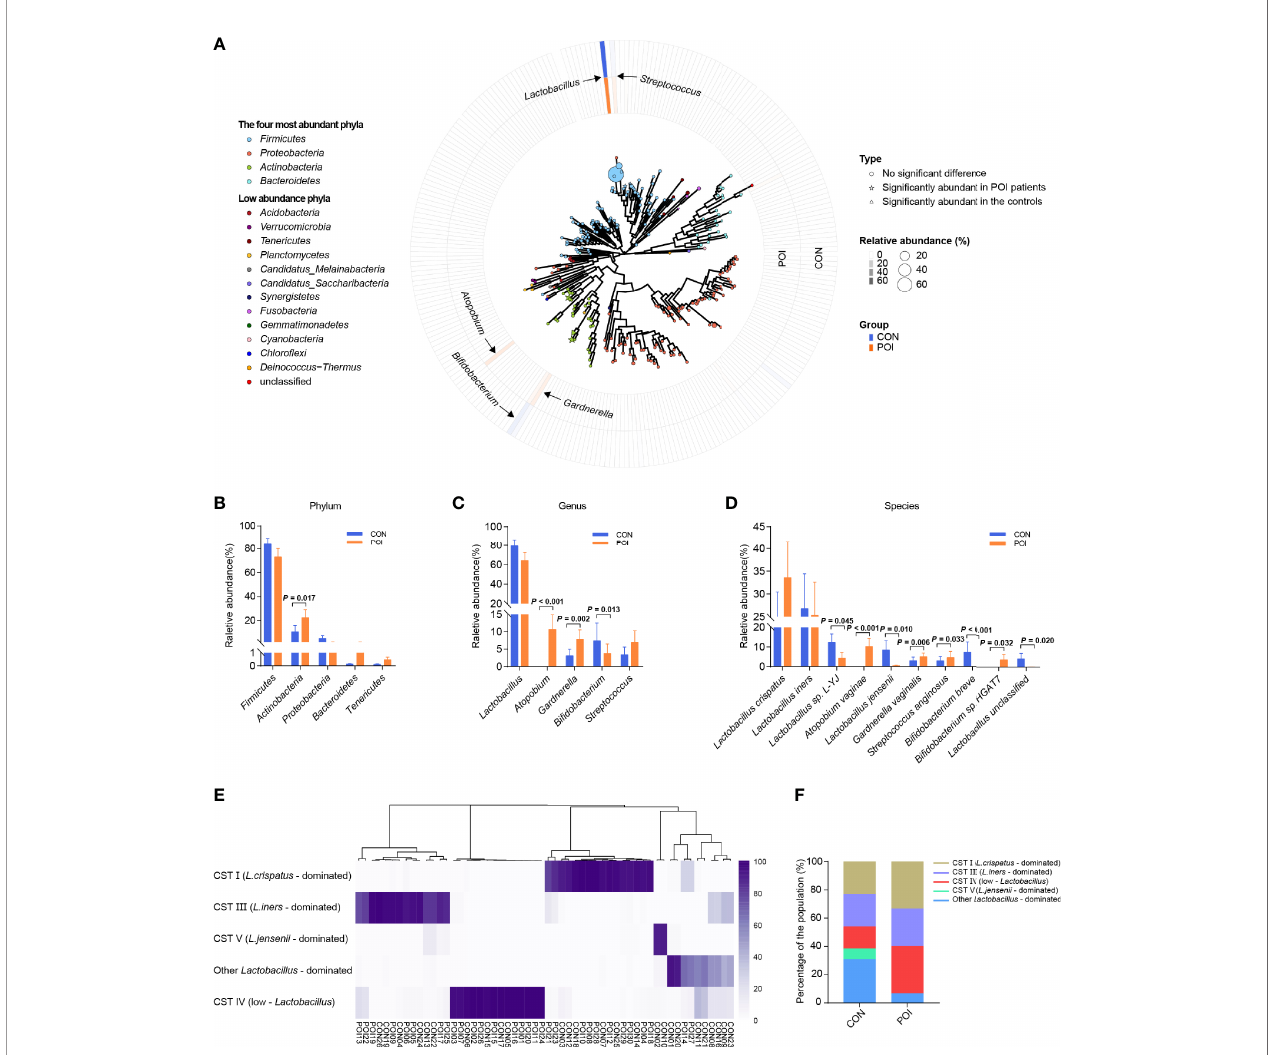
FIGURE 1 | Comparison of vaginal microbiota composition of women with POI and healthy controls. (A) A map of vaginal microbiota composition in all samples. The vaginal microbiome is dominated by four phyla: Firmicutes , Actinobacteria , Proteobacteria , and Bacteroidetes . In the center is a phylogenetic tree of microbes abundant in the vaginal microbiota. Bacteria signi fi cantly abundant in POI patients are indicated by stars, bacteria abundant in the controls are indicated by triangles, and those that have no signi fi cant difference are indicated by circles. A larger star/triangle/circle at the end indicates a higher relative abundance of the corresponding genus. The outer rings correspond to the relative abundance of each genus in each group and are color-coded by group, with darker colors indicating higher relative abundance. (B – D) Differences in relative abundance at phylum, genus, and species levels. (E) Cluster analysis of dominant vaginal bacterial taxa found in 56 participants. (F) . Percentage of each cluster in the two groups. CST, community state type. P < 0.05 was considered statistically signi fi